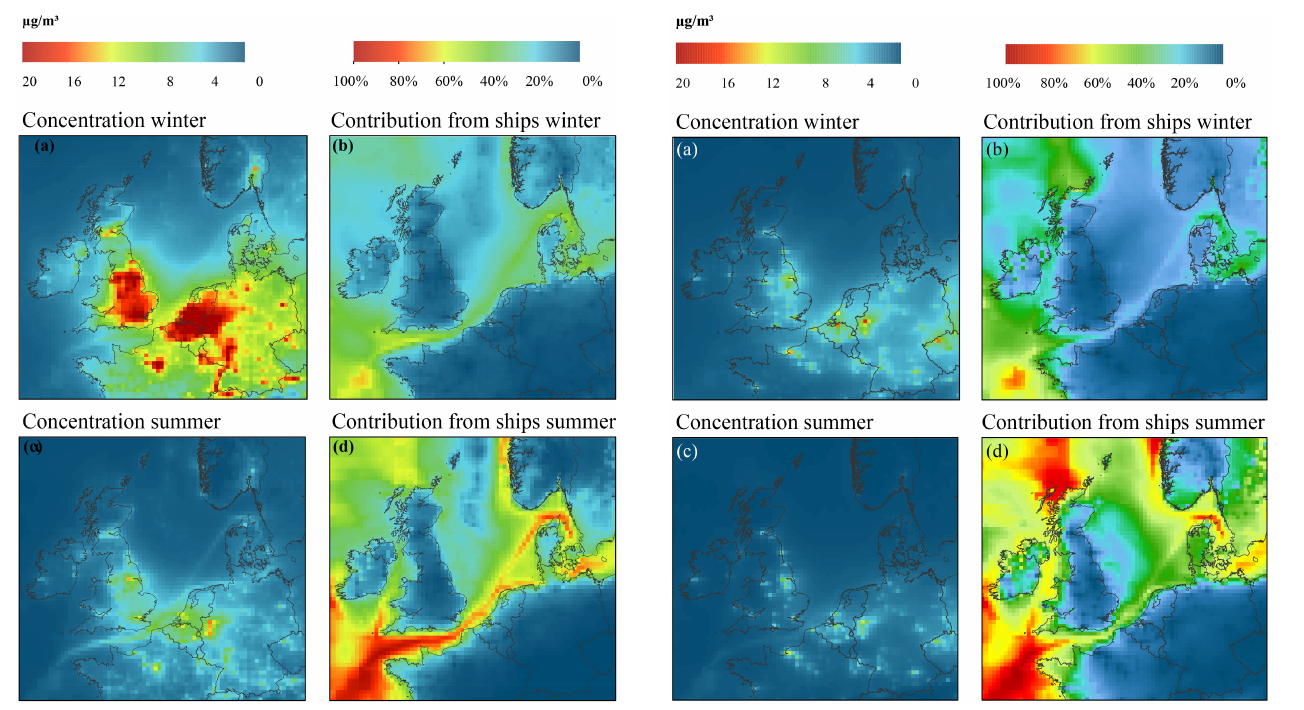
Figure 9. SO 2 in summer and winter and the relative contribution of ship